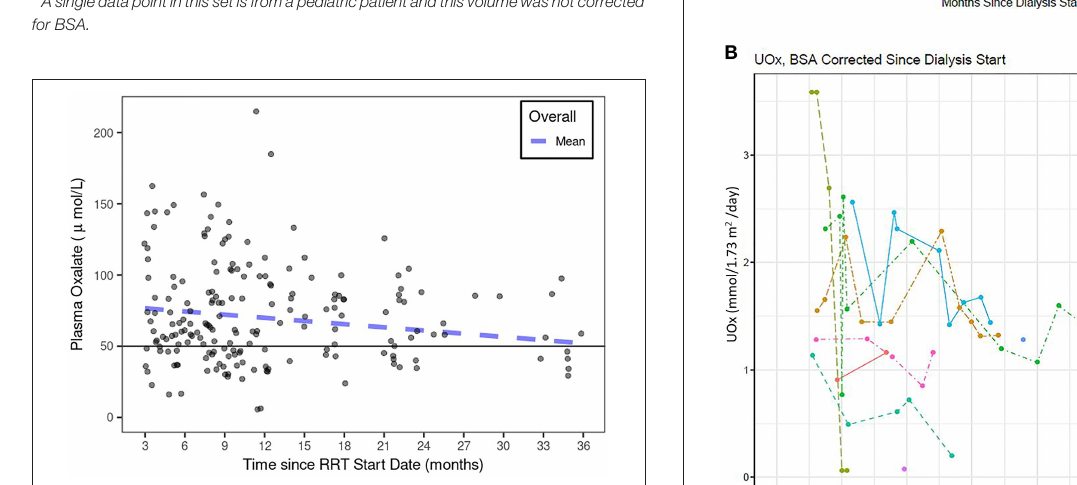
FIGURE 2 | pOx over the course of RRT in PH1. The mean pOx declined slightly over time (though not statistically significant) with RRT, but remained above 50 µ mol/L using a linear mixed-effects model with subject-specific intercept and slopes.